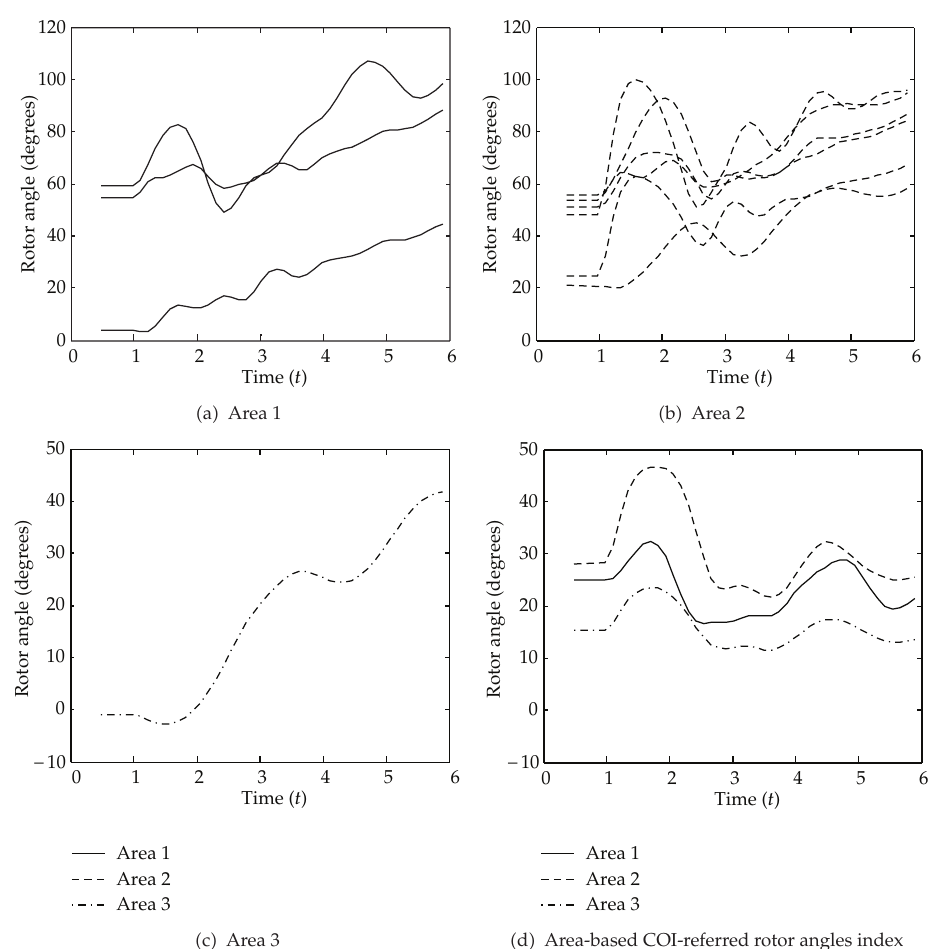
Figure 4: Case 2: the system remains stable after a fault at Line 8 (cid:5) Area 2 (cid:6)